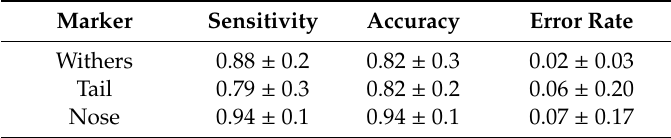
Table 2. Mean ± SD of performance criteria for machine vison technics.